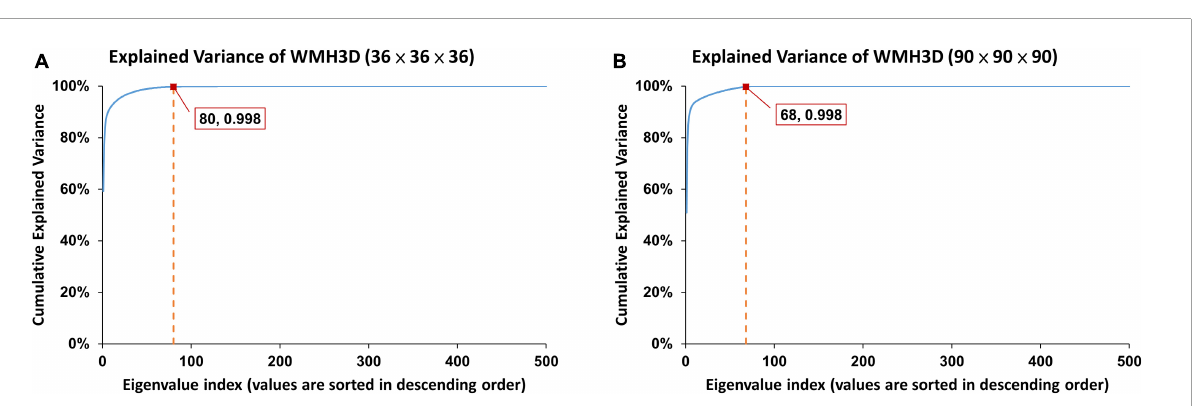
FIGURE5 To maintain 99.8% variance of the two lesion size groups, (A) the first 80 principal components and (B) the first 68 principal components were chosen for group S s and group S l , respectively.